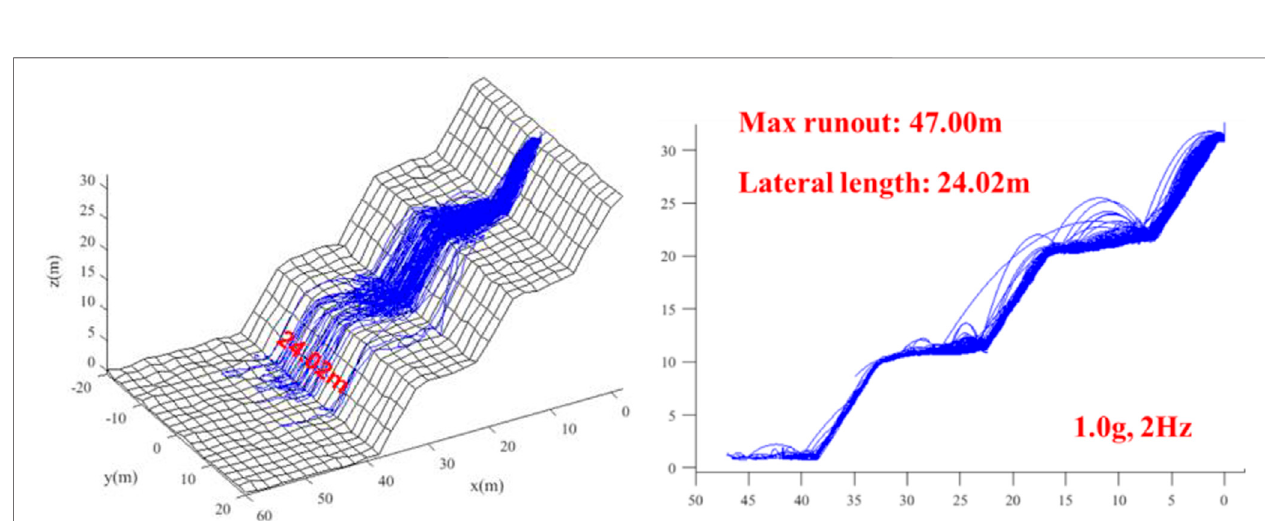
FIGURE 12 | Rockfall trajectories under seismic load, sine wave, 1.0 g, 2 Hz, 25 s (C4).